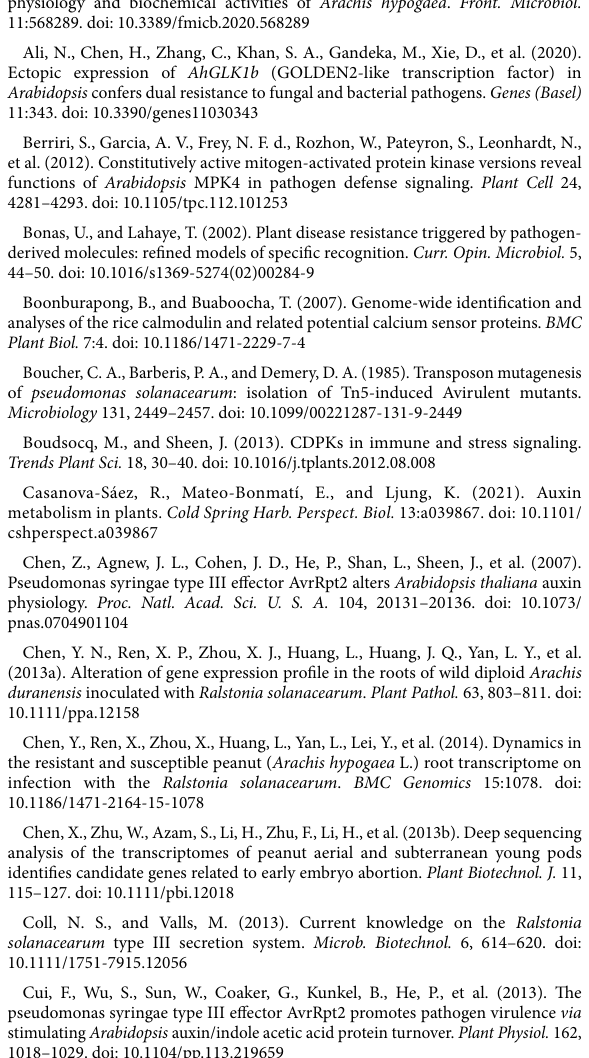
SUPPLEMENTARY TABLE S8 The results of KEGG enrichment analysis of PAMPs induced resistance- response DEGs. SUPPLEMENTARY TABLE S10 The results of KEGG enrichment analysis of PAMPs induced susceptibility- response DEGs. SUPPLEMENTARY TABLE S12 The results of KEGG enrichment analysis of T3Es induced resistance- response DEGs. SUPPLEMENTARY TABLE S14 The results of KEGG enrichment analysis of T3Es induced susceptibility- response